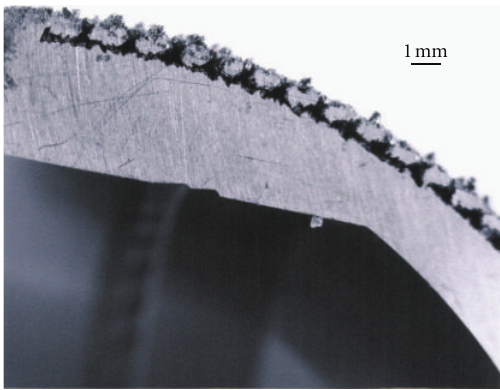
Figure 14: Section view of acetabular cup in Figure 13 showing porous-mesh surface region.